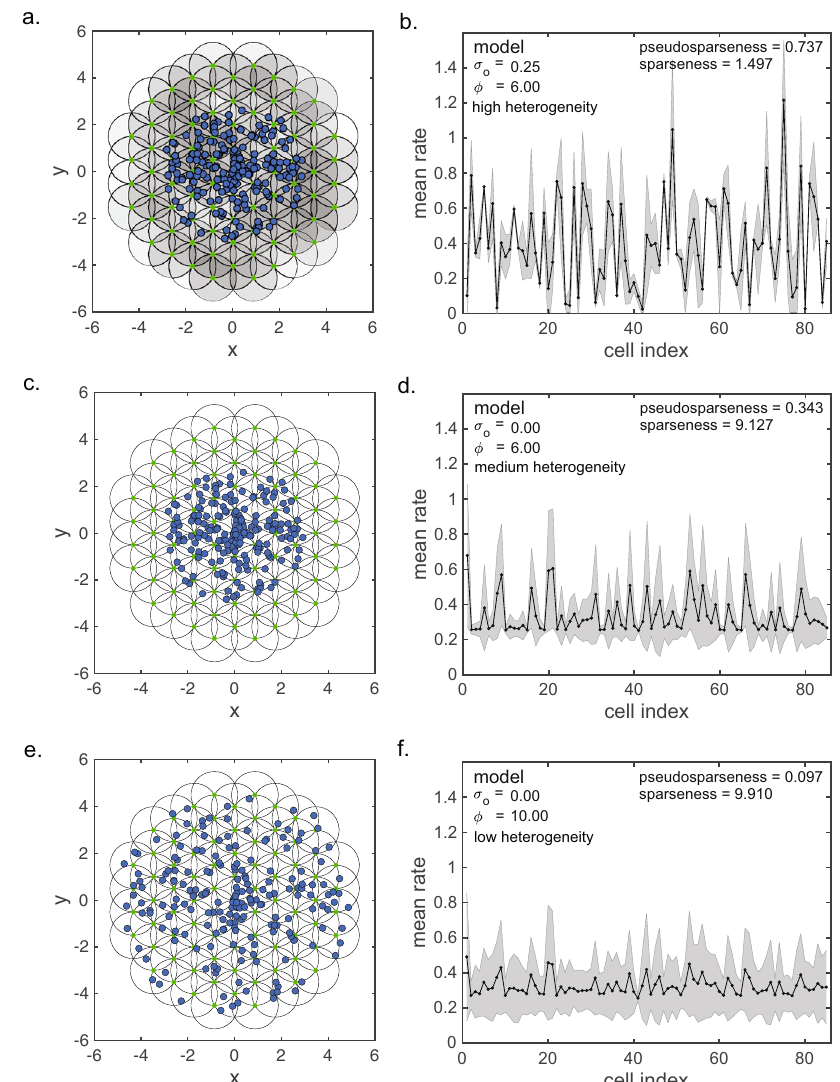
Fig. 7 Model for generating various level of pseudosparseness in a population of receptive fi elds activated by random stimuli. Top row: high pseudosparseness conditions. a Hexagonal grid of overlapping receptive fi elds in a 2D feature space (e.g., position, shape, etc.). Each receptive fi eld has a Gaussian tuning curve in the feature space described in Eq. (2), with a small green dot indicating receptive fi eld center and circle indicating receptive fi eld drawn at space constant σ = 2 (in arbitrary units). Receptive spacing is η = 1.0 and receptive fi eld dispersion (size of circular boundary of green dots) is γ = 10.0. Additional parameter values are gain mean μ G = 1.0, gain standard deviation σ G = 0.25, offset mean μ O = 0.25, and offset standard deviation σ O = 0.25. Blue dots indicate a random set of stimuli. Stimulus set dispersion (size of circular boundary of blue dots) is ϕ = 6. b Resulting response spectrum, showing high level of pseudosparseness = 0.737. Second and third rows: examples of two conditions producing lower pseudosparseness, namely, reducing the response offset level and increasing the stimulus set dispersion. These conditions make population responses less heterogeneous. c Receptive fi eld mosaic with offset standard deviation reduced to σ O = 0.0, indicated by receptive fi eld gray levels being white. d Resulting response spectrum, showing a lower pseudosparseness compared to when response offset level is higher. e Receptive fi eld mosaic with stimulus set dispersion increased to ϕ = 10, in addition to response offset again set to zero. f Increasing the stimulus set dispersion leads to further decrease in pseudosparseness. Gray error bars represent standard An example con fi guration of the model is shown in Fig. 7a. The black circles show Gaussian receptive fi elds (drawn at the level of σ in Eq. (2)), while the blue dots indicate stimuli. For this example the RF diameter was σ = 2 and the spacing between RF centers was η = 1 (both in arbitrary units), while the number of fi elds γ (the diversity of receptive fi elds tunings in the feature stimuli was n = 200. The full set of model parameters are listed in space), and the dispersion of the stimulus set ϕ (the diversity of the caption for Fig. 7a. The population response spectrum the stimulus set in the feature space). On the other hand, resulting from this model is shown in Fig. 7b and has high pseudosparseness is not sensitive to the number of stimuli in the pseudosparseness = 0.737.